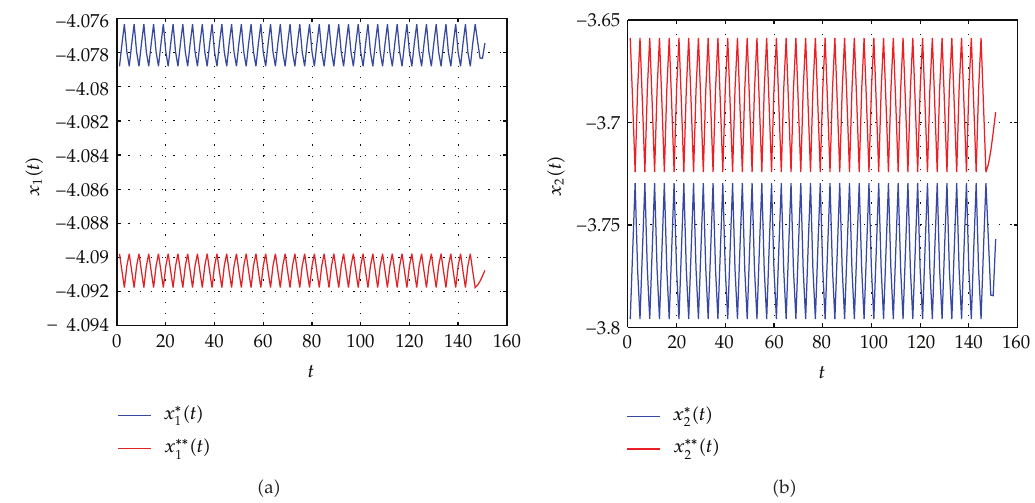
Figure 1: Blue lines stand for x ∗